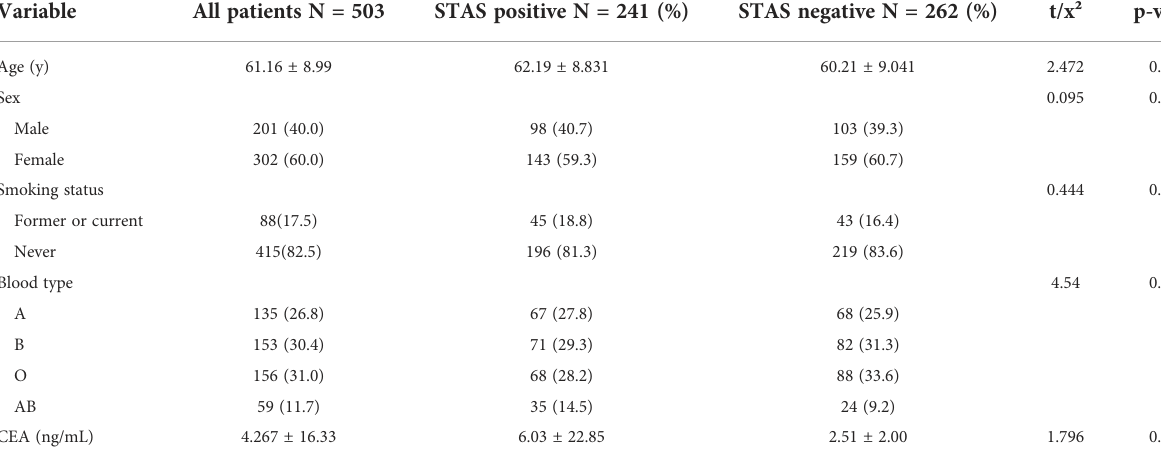
TABLE 1 Clinical features of 503 patients with invasive lung adenocarcinoma (n [%]).